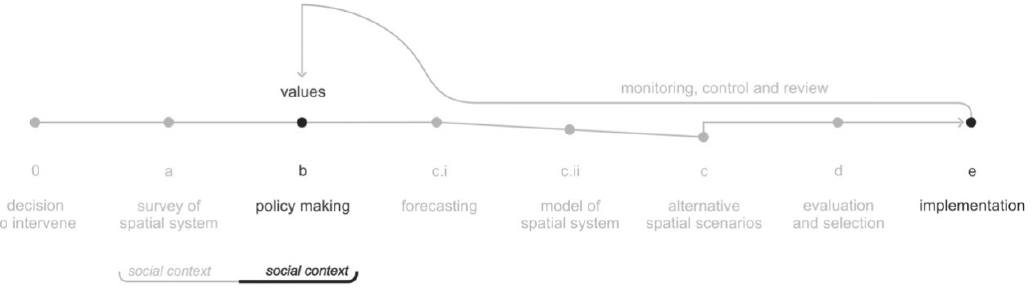
Figure 6. The elements of pragmatic land-use planning, according to Harrison [16], in diagrammatic form, with the comprehensive model’s components in the background. Gray circle: lack of the corresponding McLoughlin component. Dark circle: the central component, also included in McLoughlin’s components. Below the axis: contextual factors.